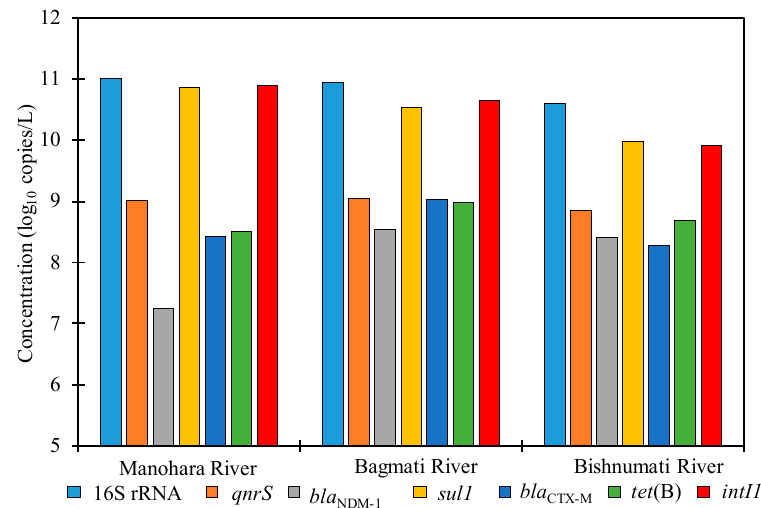
Figure 1. Absolute abundance of ARGs in river water.